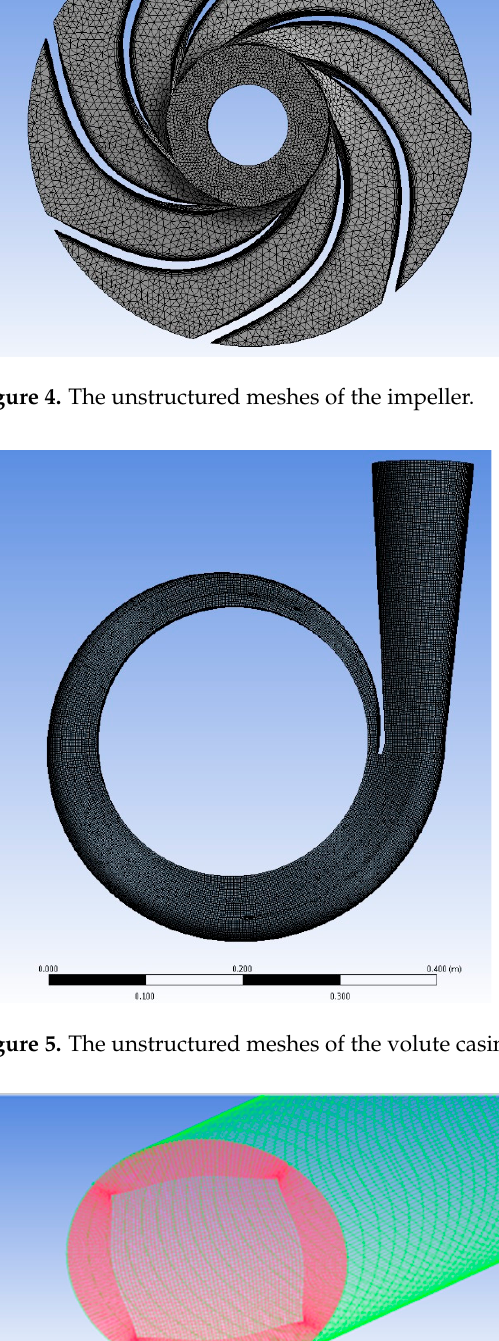
Figure 7. The entire unstructured centrifugal pump system for numerical simulation. 2.5. Process of the Optimum Design The subject (see Equation (20) and the design variables and goal functions are estab- lished. Equation (21) provides the following description of the multi-objective optimiza- tion design process: (i)